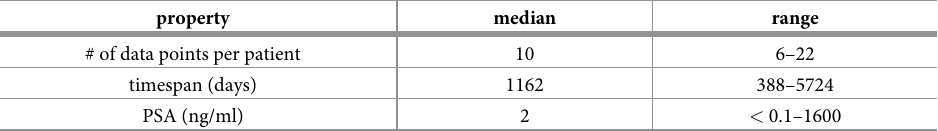
Table 1. Summary of the pre-treatment dataset.